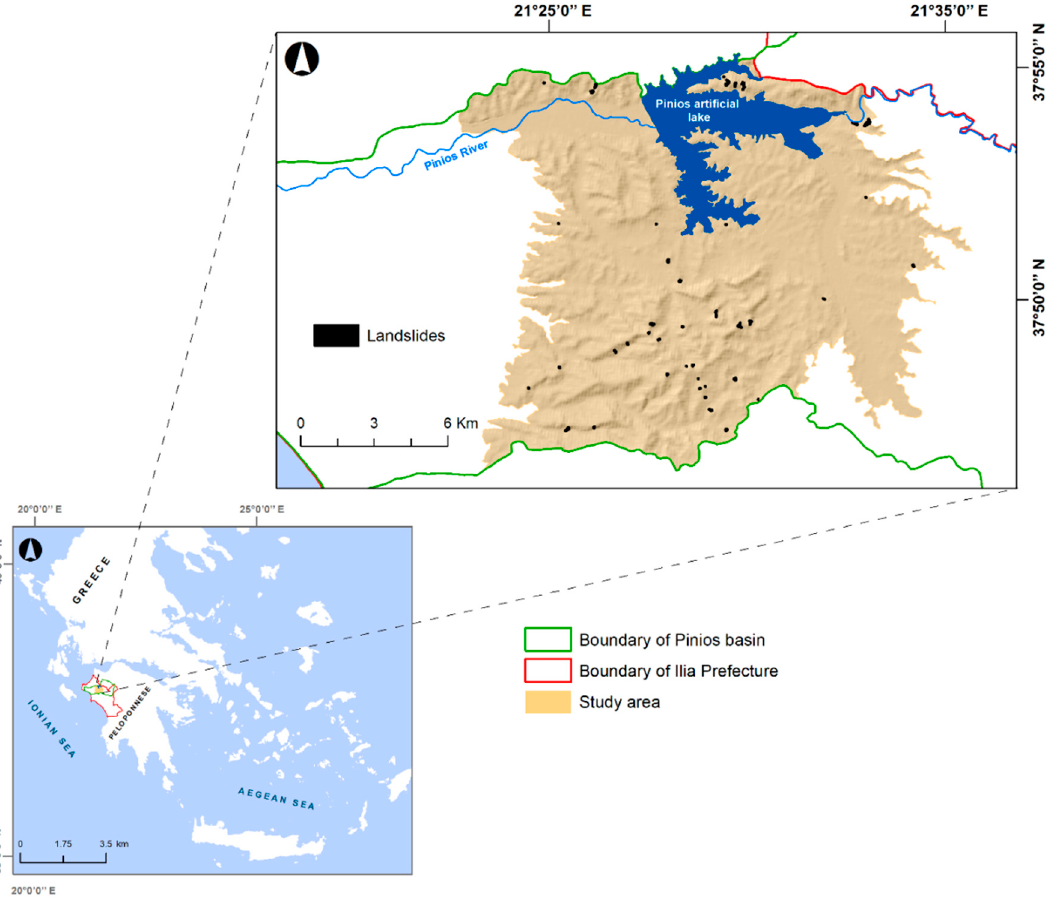
Figure 1. The study area and the locations of events from the landslide inventory. Following the typical landscape of Ilia Prefecture, the study area can be characterized as an agricultural region at a low altitude (mean altitude at 154 m above sea level). Het- erogeneous croplands or fields mixed with natural vegetation represent the predominant agricultural lands. More than 30 settlements are situated within its boundaries, containing 5400 inhabitants according to the official 2011 census